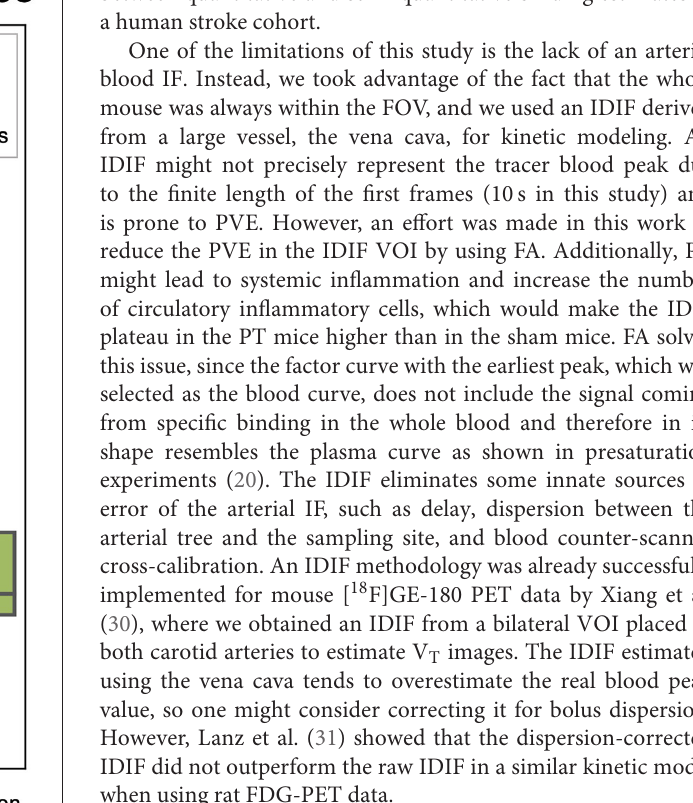
specific binding compared to [ 18 F]GE-180 (11). Other potential reasons could be a different species (rats vs. mice) and ground truth estimation method (SRTM vs. reference-tissue Logan